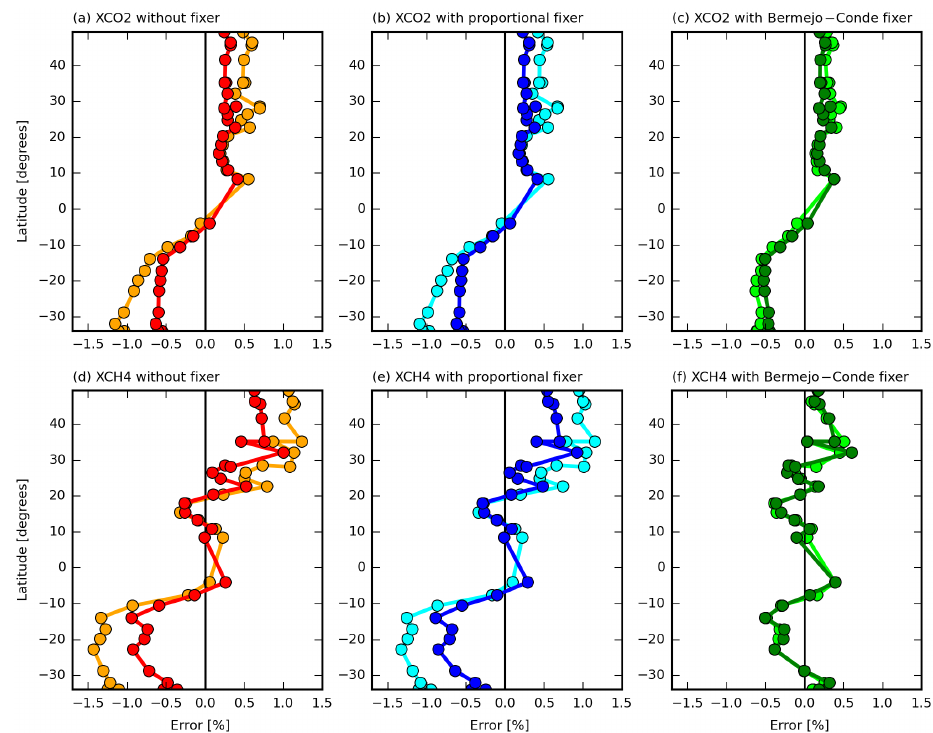
Figure 9. Error (%) of modelled latitudinal monthly mean (7 March to 10 April) distribution computed as (MODEL − OBS)/OBS using dif- ferent tracer mass fixers and different resolutions for (a–c) XCO 2 and (d–f) XCH 4 with respect to the observed distribution from Polarstern . Dark and light colours correspond to the simulations at low and high resolution